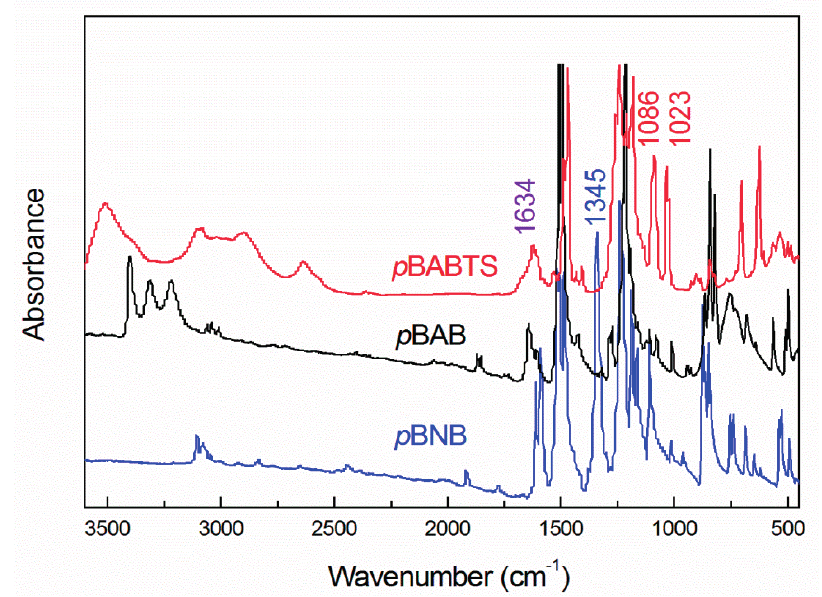
Figure 2. FTIR spectra of p BNB, p BAB and p